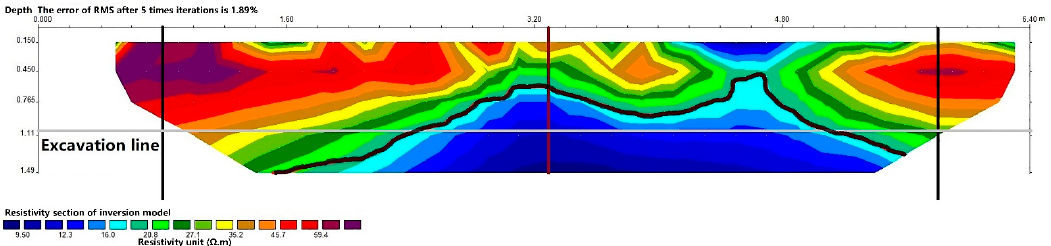
Figure 13. Photographs of GPR in the vertical direction.